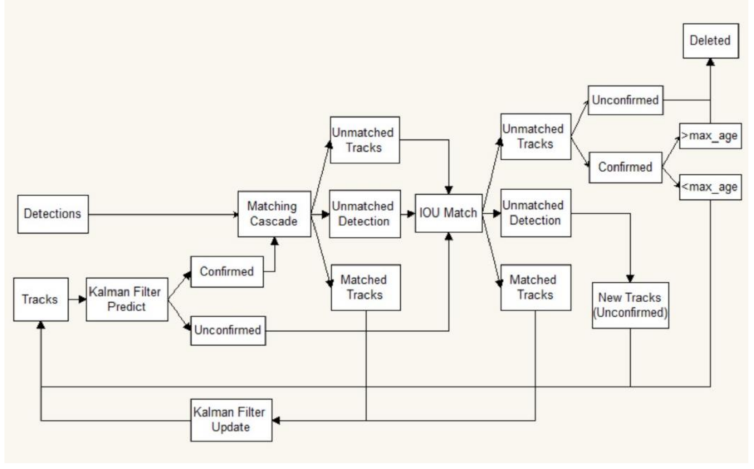
Figure 2. Object tracking procedure of DeepSORT